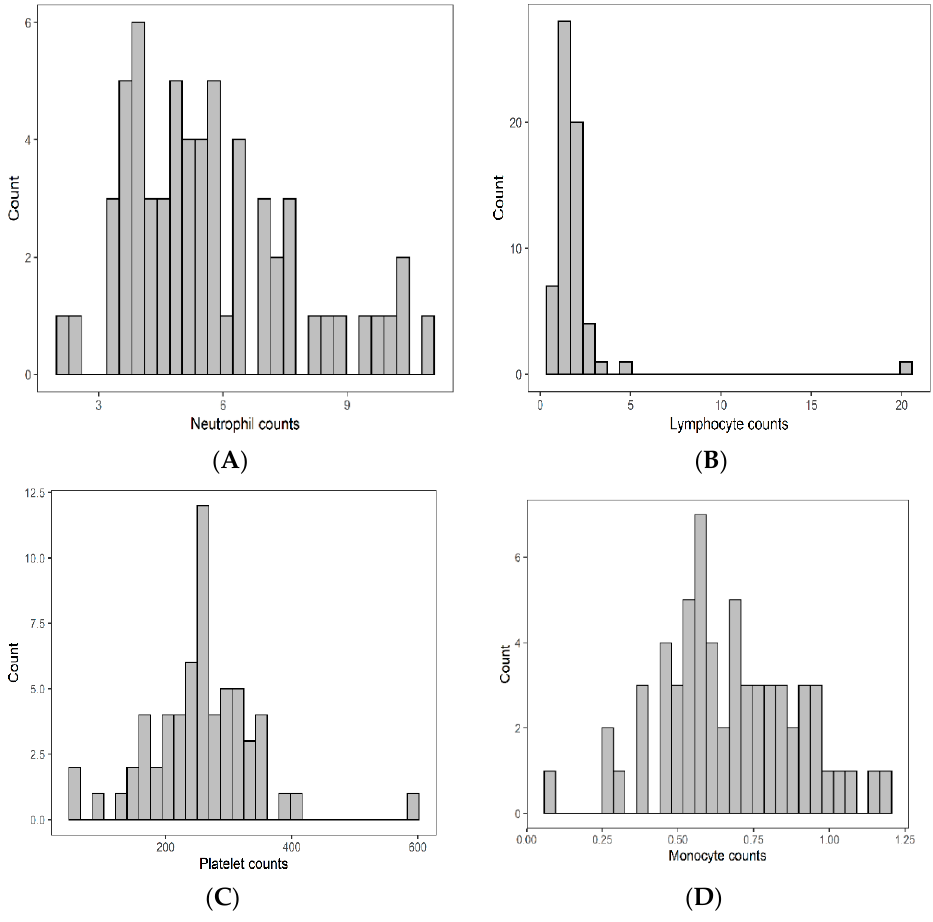
Figure 1. Pretreatment distribution of neutrophils ( A ), lymphcytes ( B ), monocytes ( C ), and platelet ( D